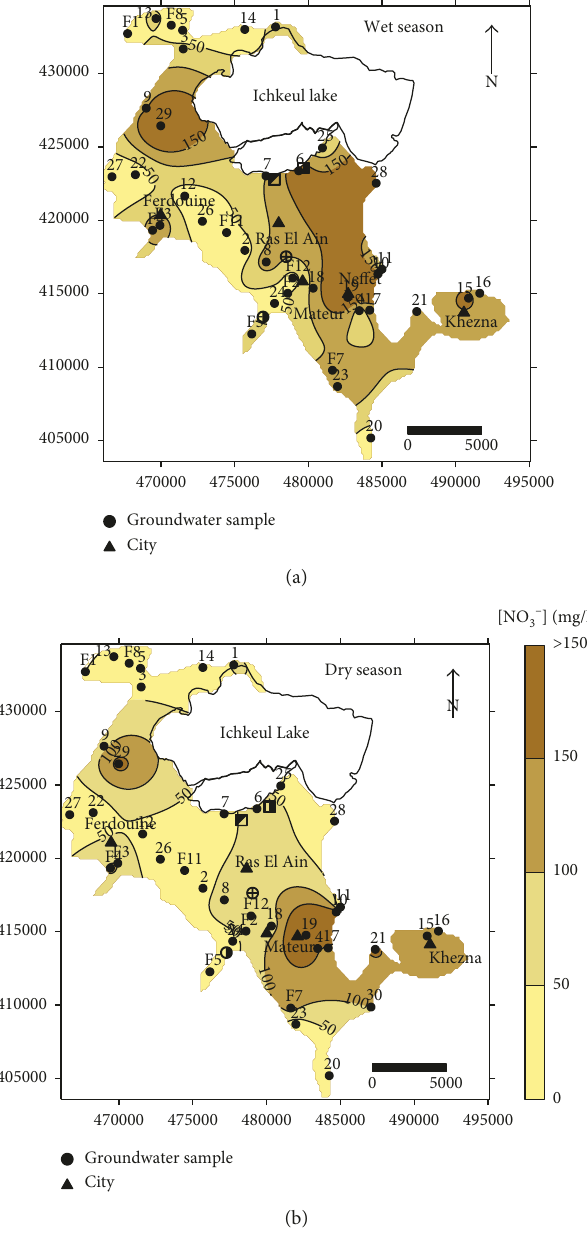
Figure 12: Spatial distribution maps of nitrate (NO season and (b) dry